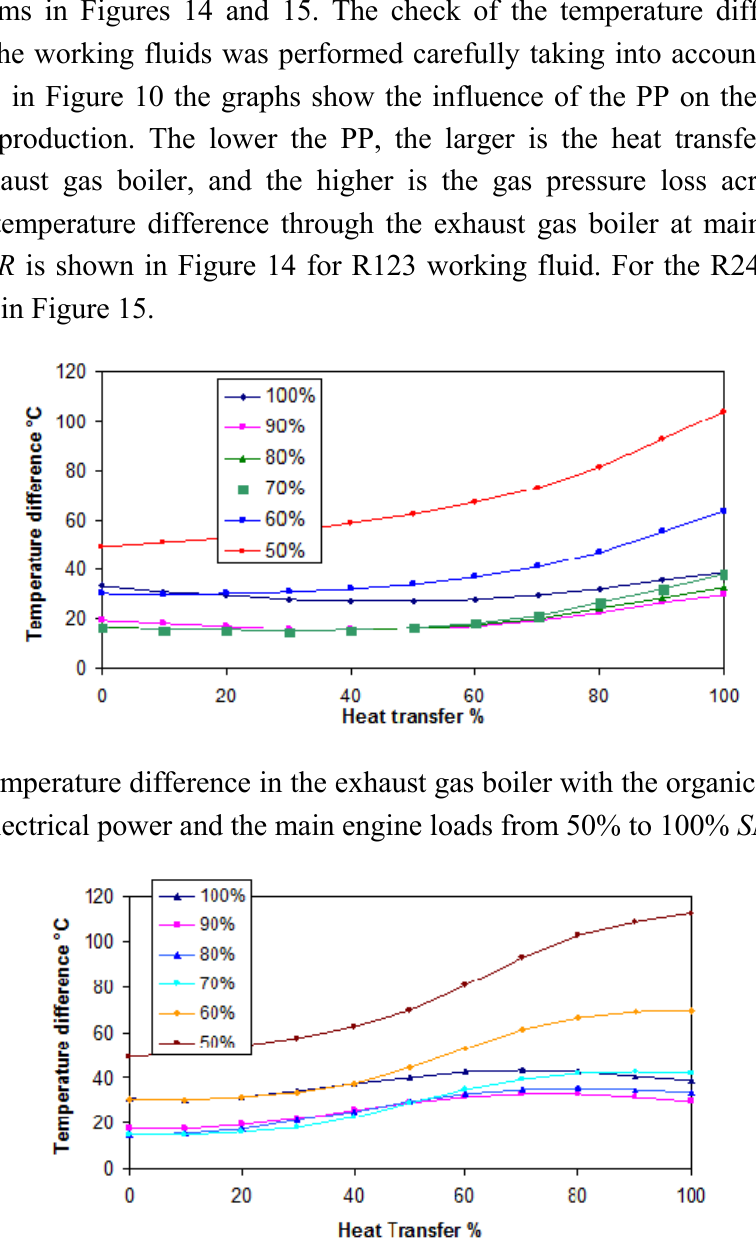
Figure 15. Temperature difference in the exhaust gas boiler with the organic working fluid R245fa at full electrical power and the main engine loads from 50% to 100%